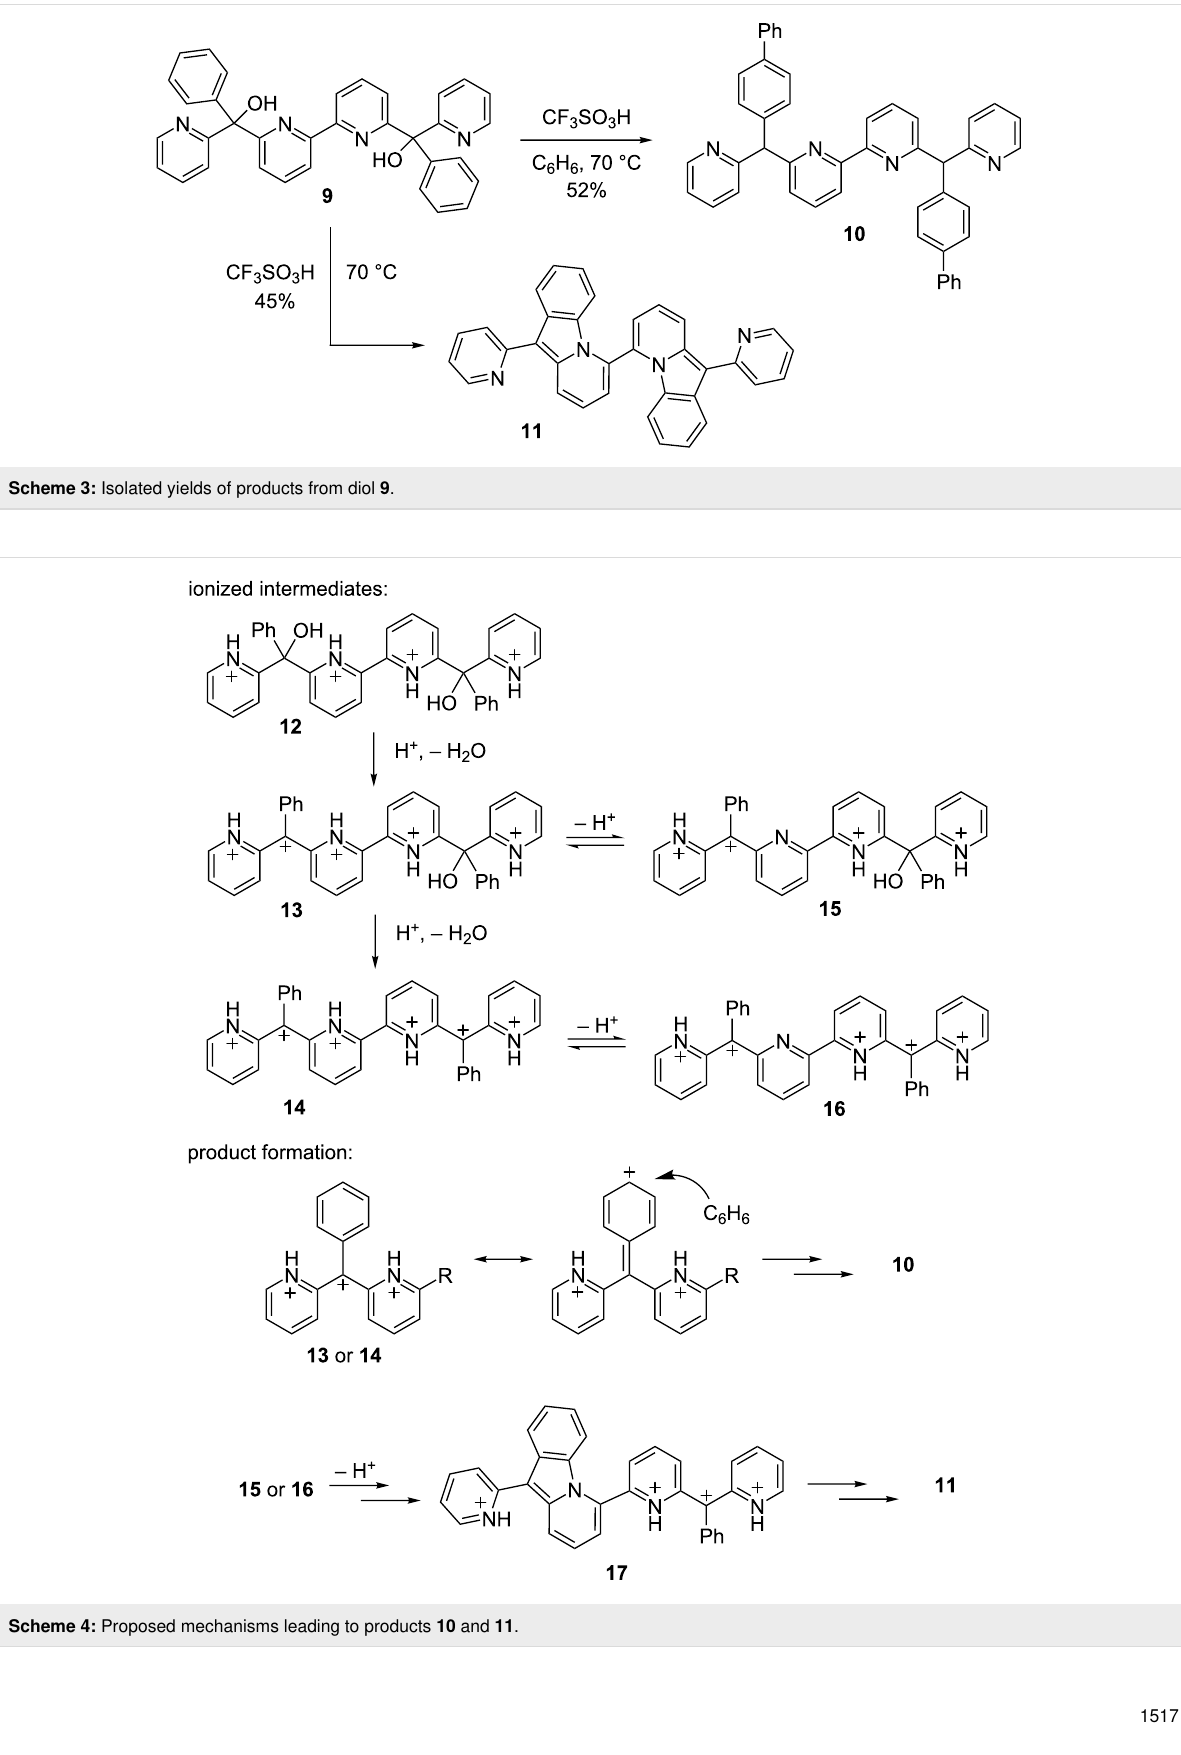
Scheme 4: Proposed mechanisms leading to products 10 and 11